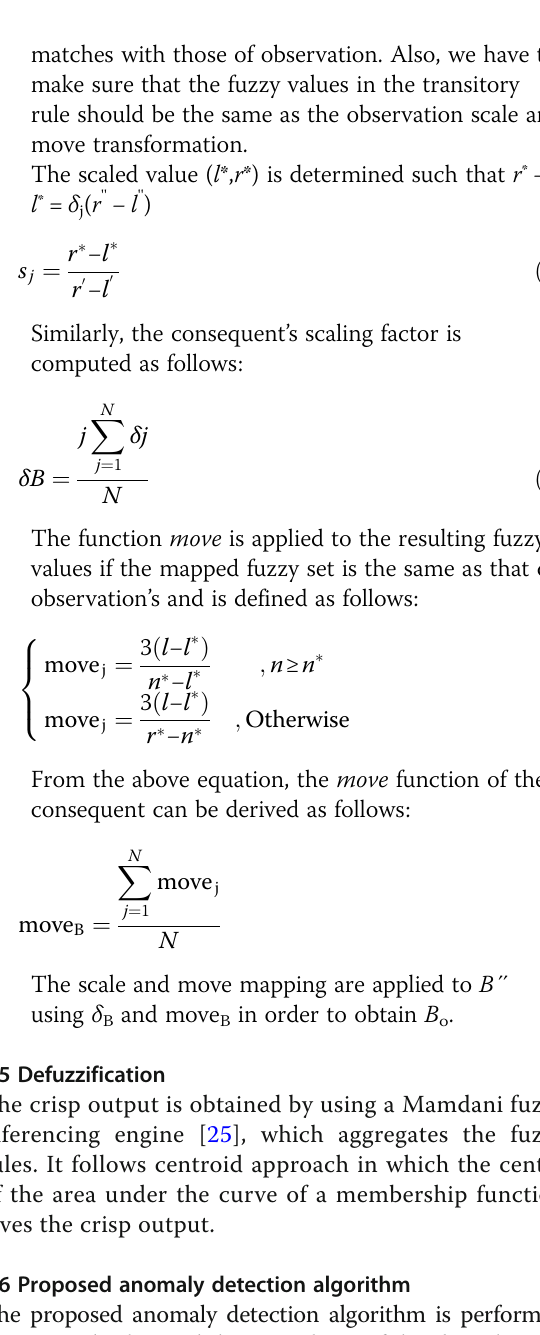
Table 2 Fuzzy rules for the proposed system CMR